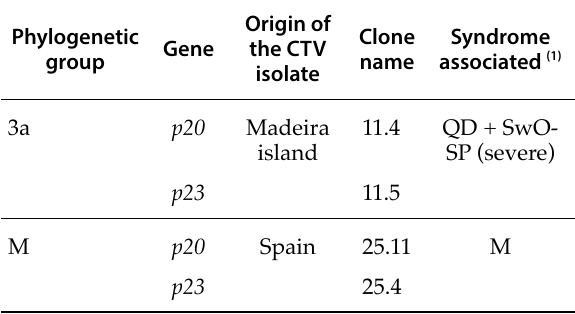
Table 1. Origin of the CTV isolates and associated syn-